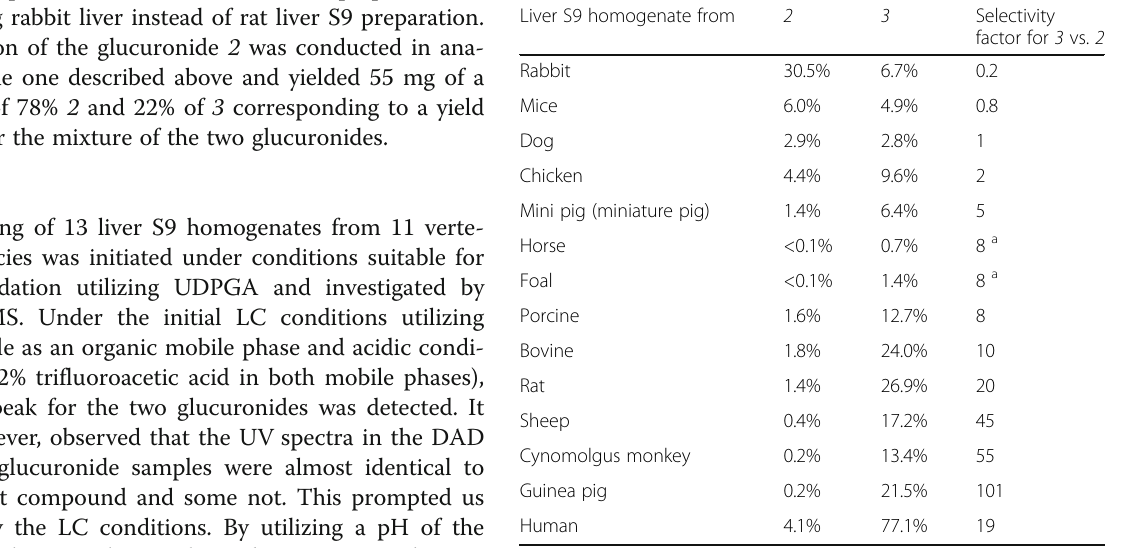
Table 1 Percentage of glucuronide formation after exposure to liver species for 20 h (DAD at 240 nm) and selectivity for forming the glucuronide 3 sorted by increasing